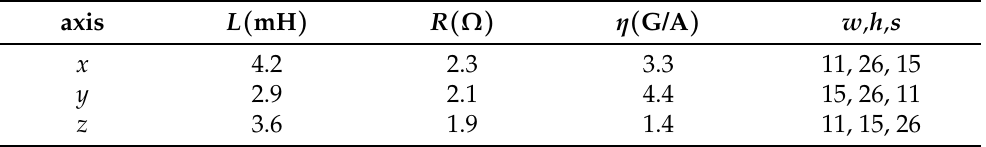
Table 1. Characteristic parameters of each pair of rectangular coils used for generating a magnetic field vector (cid:126) B at the location of atoms. The last column shows the width w , the height h , and the separation s between coils in each pair, given in cm. L —inductance, Ω —resistance, and η —the conversion coefficient relating the magnetic field to the current flowing through each pair of coils. axis L ( mH ) R ( Ω ) η ( G/A ) w , h , s x